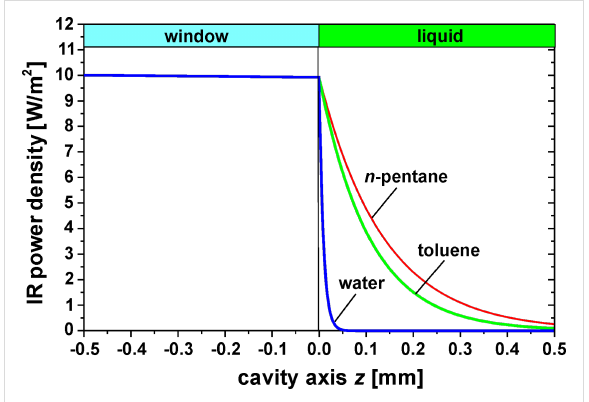
Figure 6: IR power density as function of the cavity axis for different liquids. Suprasil ® 300 was used as the material for the window with an absorption coefficient of 0.16 cm − 1 [23]. For gas, a thin absorbing film on the inner glass surface is assumed where all the radiation is absorbed.